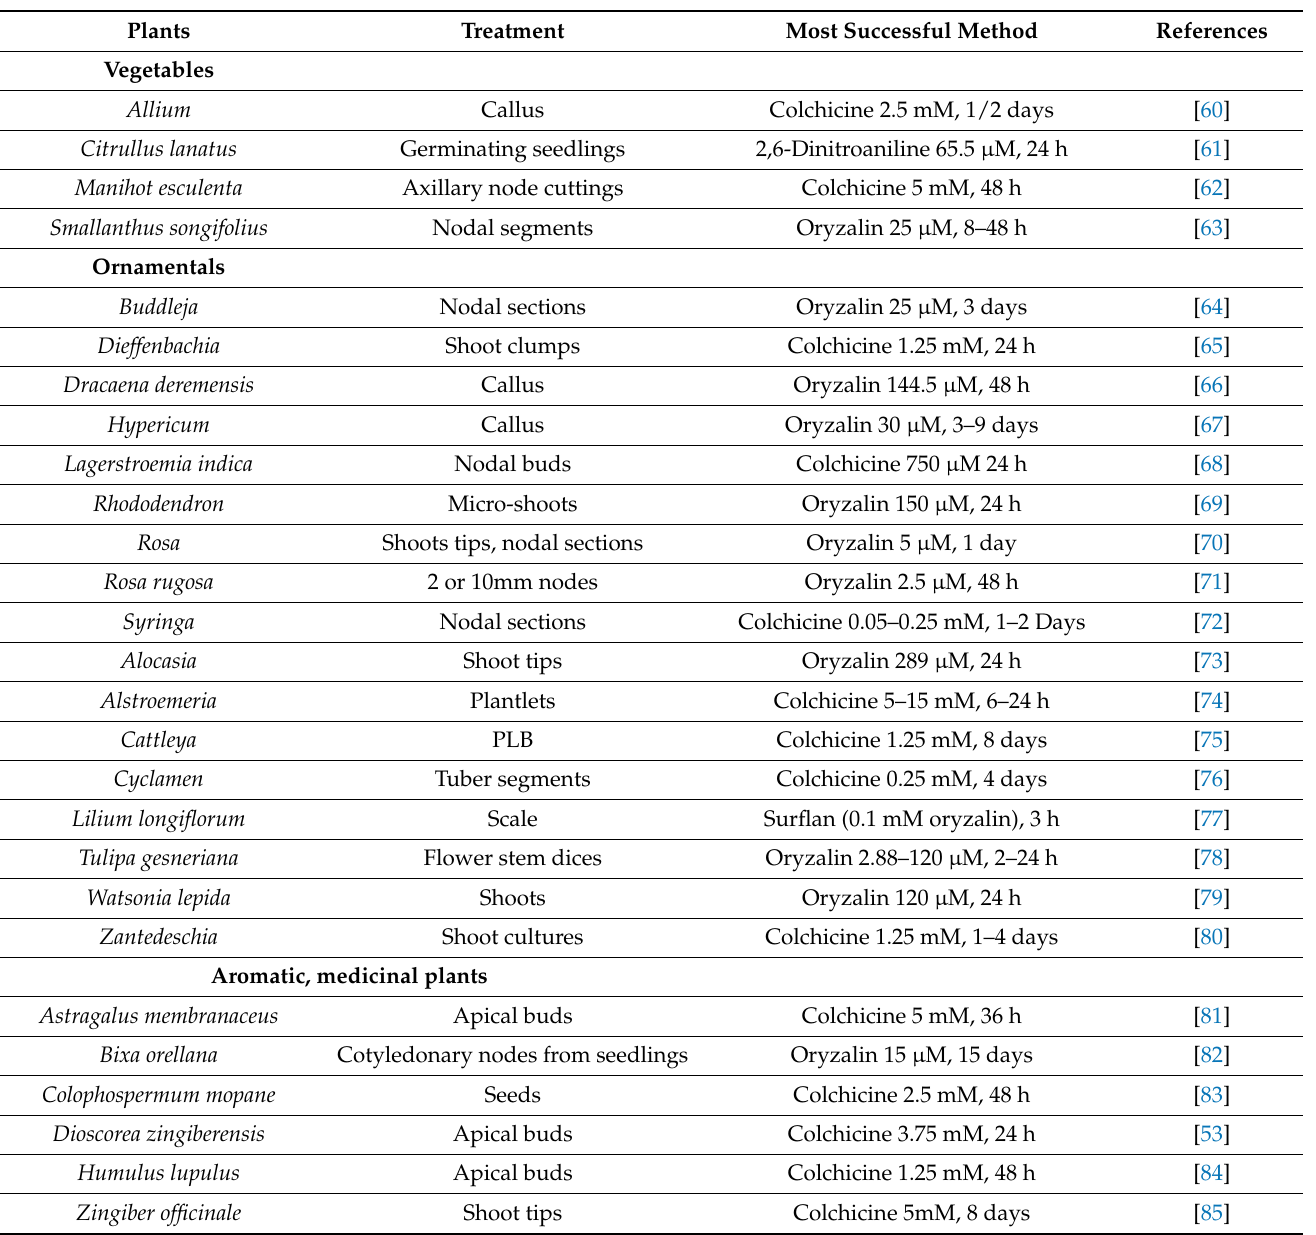
Table 1. Commonly used methods for polyploidization in